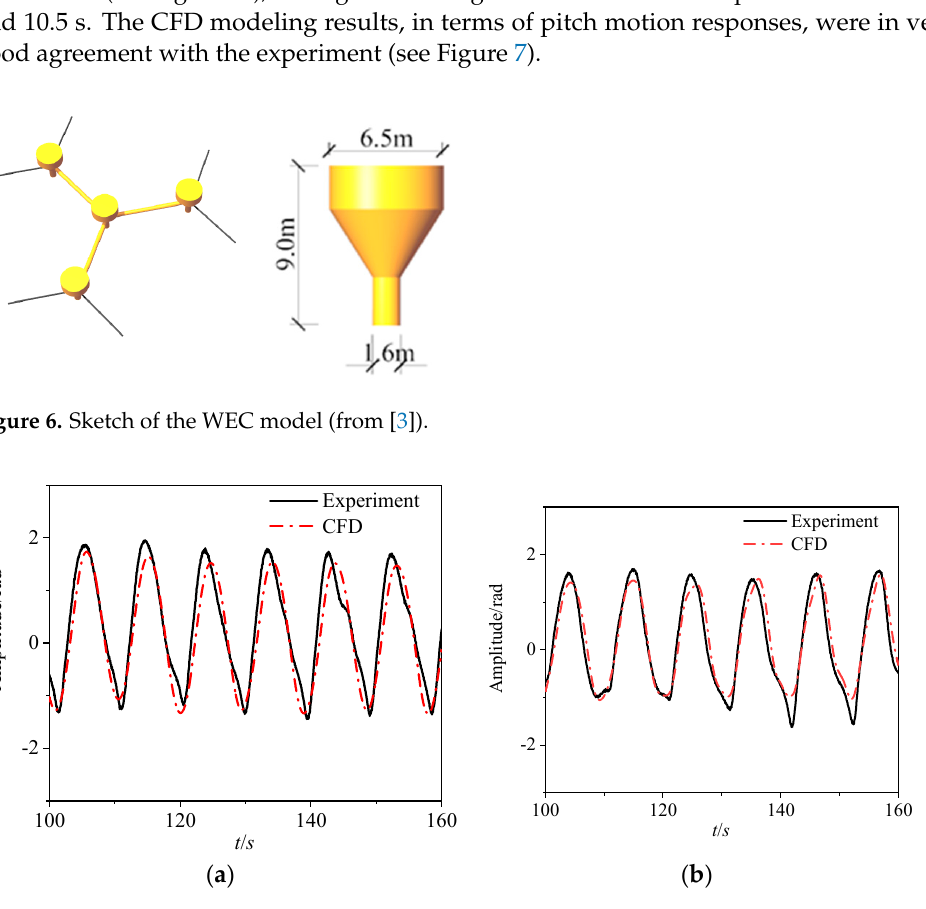
( b ) H = 1.5 m and T = 10.5 s (from [3]).